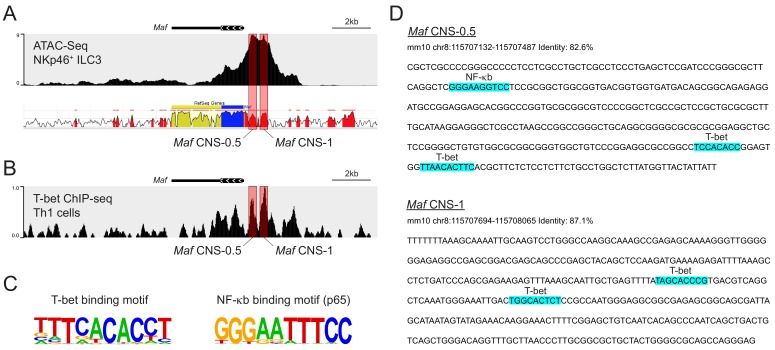
Evidence for direct binding of T-bet to Maf in NKp46+ ILC3s.(A) Representative ATAC sequencing tracks across the Maf locus of NKp46+ ILC3s (Shih et al., 2016). ATAC sequencing peaks overlap with two conserved non-coding sequences 0.5 kb (CNS-0.5) and 1 kb (CNS-1) upstream of Maf (red boxes). (B) Representative T-bet ChIP sequencing tracks across the Maf locus of Th1 cells (Gökmen et al., 2013). Prominent T-bet binding peaks overlap with ATAC sequencing peaks within Maf CNS-0.5 and CNS-1 regions (red boxes). (C) T-bet and NF-κb binding motifs as defined by HOMER software (Heinz et al., 2010). (D) In silico analysis identifies T-bet and NF-κb binding sites within Maf CNS-0.5 and CNS-1 regions (highlighted in blue). ATAC and ChIP sequencing tracks were visualized using the WashU browser from the Cistrome project (Mei et al., 2017).